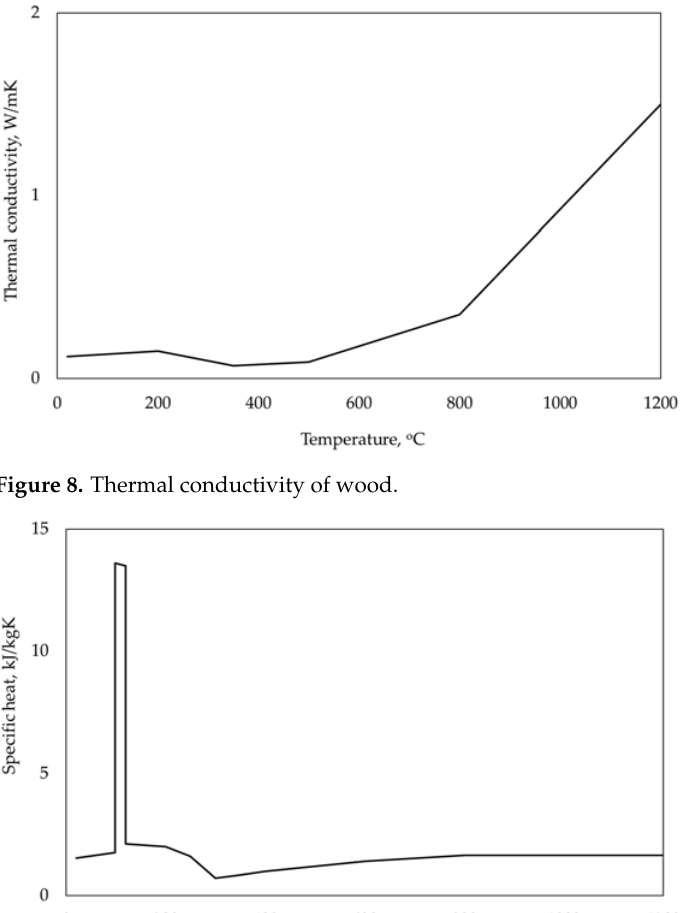
Figure 9. Specific heat of wood.